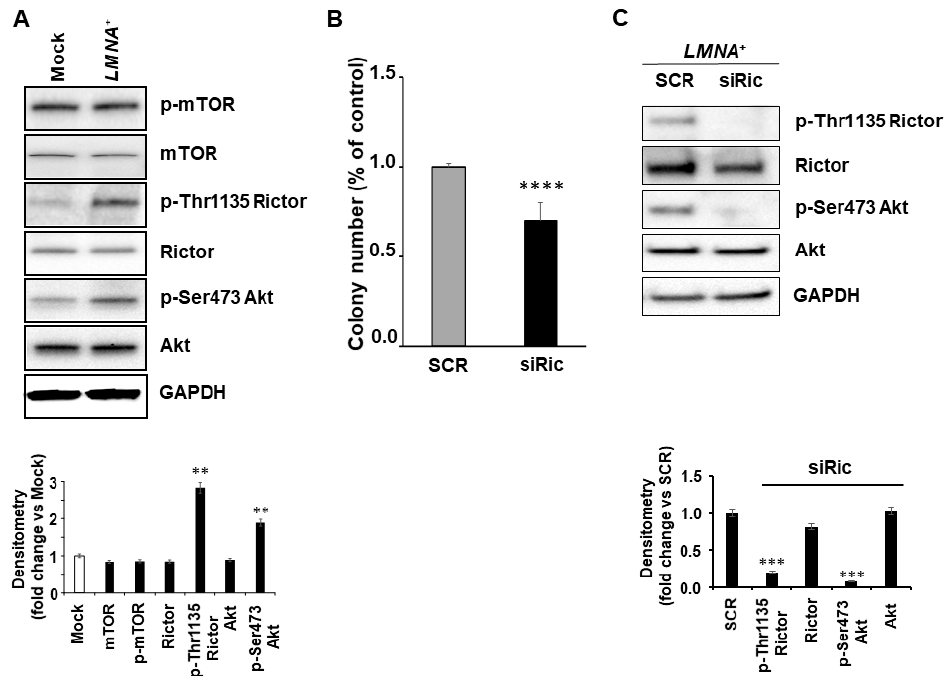
Figure 6. Rictor inhibition is associated with reduction of colony formation. ( A ) Top, representative western blot of the indicated proteins in CTRL and LMNA + T98G cells; bottom, blots densitometry as analyzed by ImageJ software. Values are averages + s.d. (n = 3), relative to mock cells of three independent experiments with similar results. GAPDH was used as loading control. Statistical significance: ** p < 0.01. ( B ) LMNA + clone was transfected with scrambled siRNA as control (SCR, 100 nM) or siRNA Rictor (siRic, 100 nM) and after 48 h from transfection the cells were analysed. Colony number as % of control are reported in siRic-treated (black) versus SCR-treated LMNA+ cells (gray). Statistical significance: siRictor-treated vs SCR-treated LMNA + cells, **** p < 0.0001. ( C ) Top panel, representative western blot of the indicated protein expression in LMNA + cells transfected with scrambled (SCR) and siRNA Rictor (siRic); bottom panel, blots densitometry as analyzed by ImageJ software. Values are averages + s.d. (n = 3), relative to SCR-treated cells of three independent experiments with similar results. GAPDH was used as loading control. Statistical significance: *** p < 0.001.